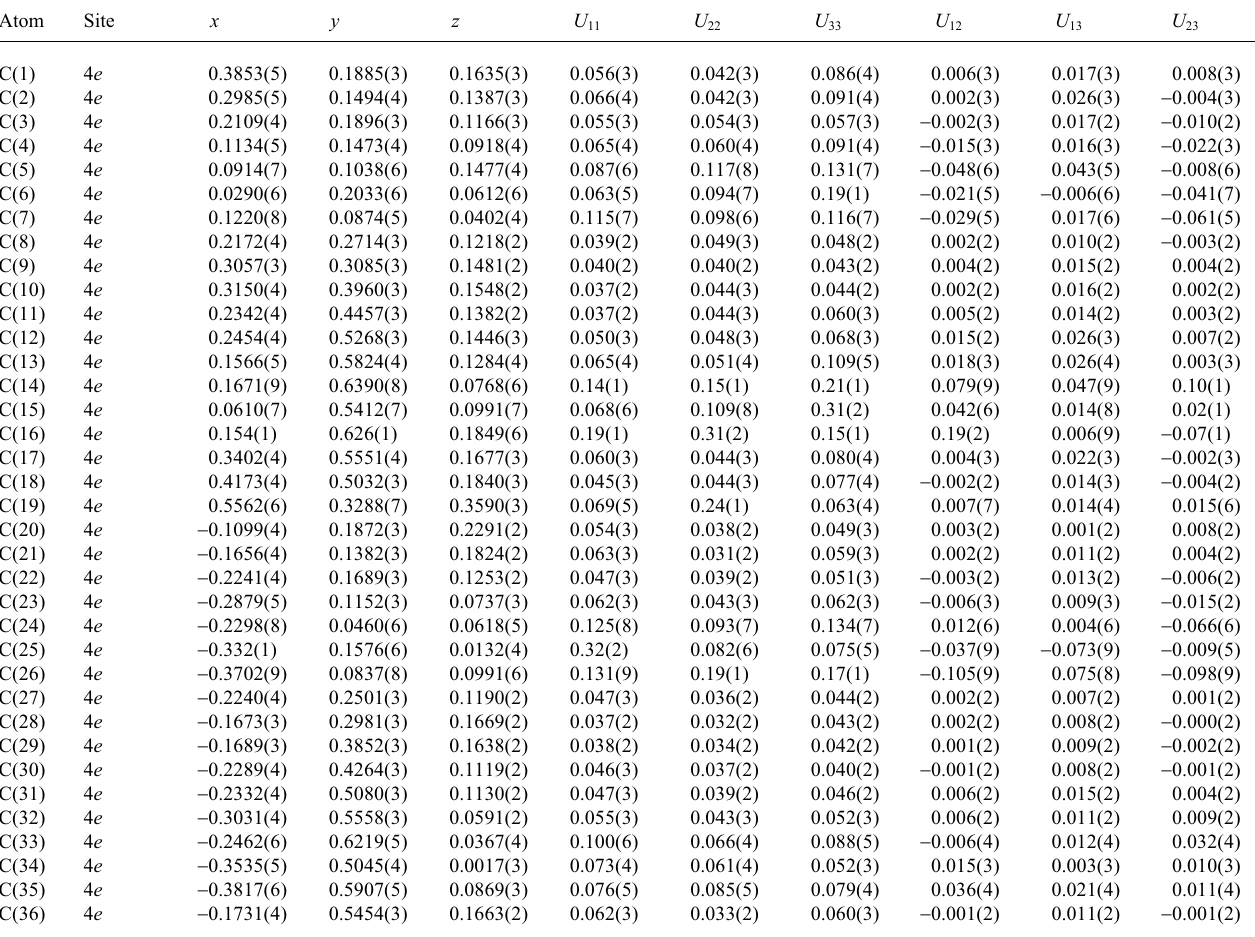
Table 3. Atomic coordinates and displacement parameters (in Å 2